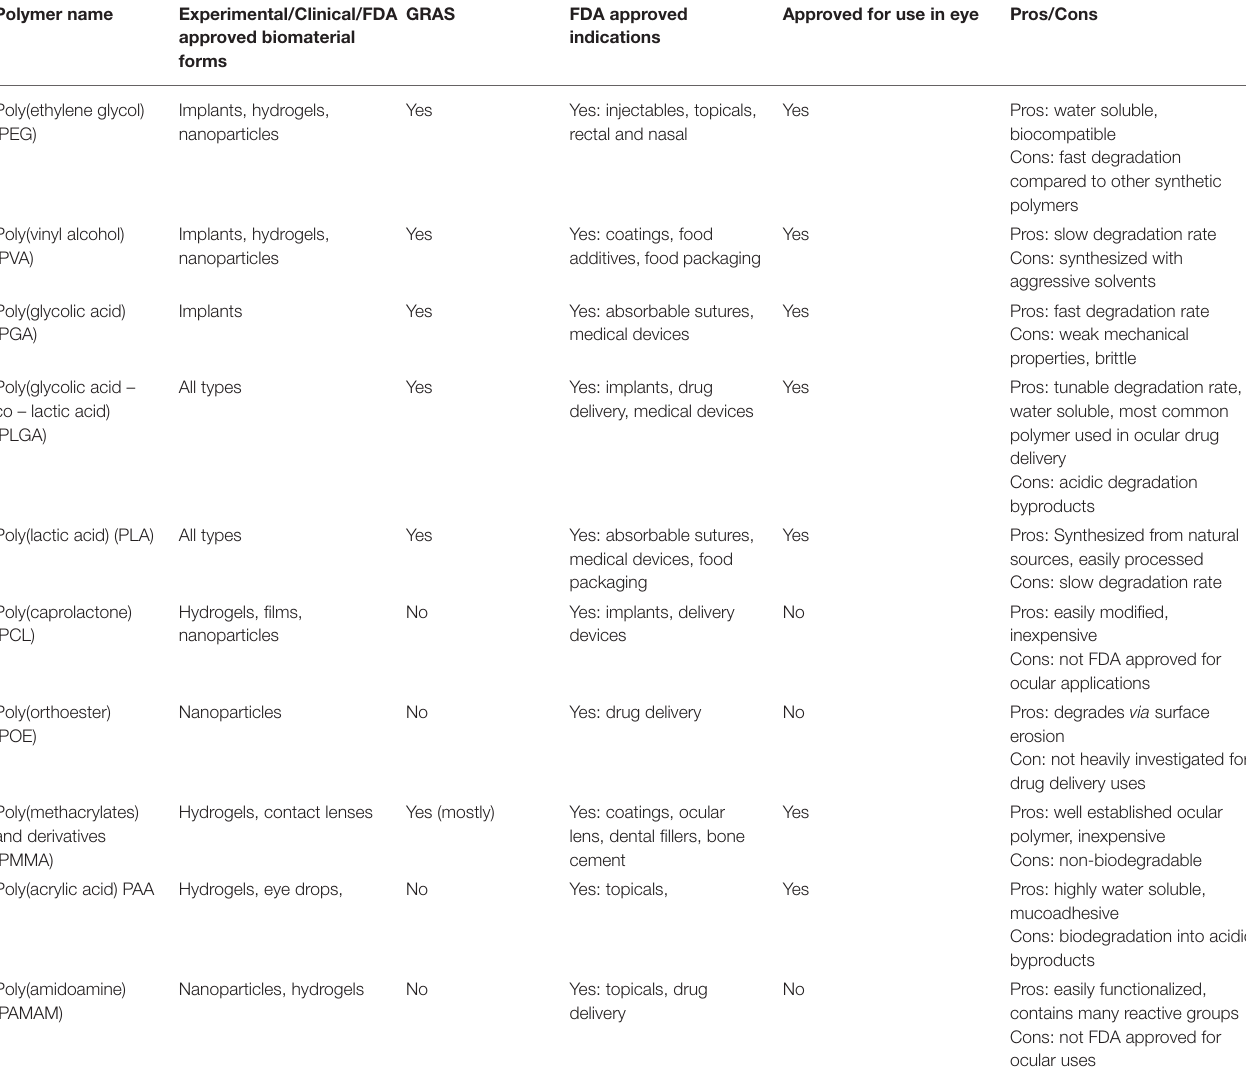
TABLE 1 | Summary of synthetic polymers, biomaterial uses, regulatory status, benefits, and disadvantages. Polymer